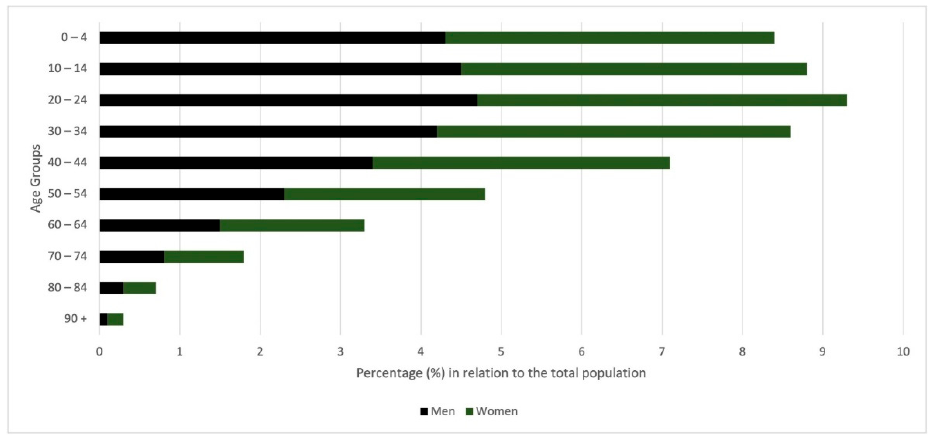
Figure 11. Brazilian Amazon age pyramid by sex, 2020. Source: [21]. The region will still benefit from a demographic bonus for longer than the rest of the country due to its late demographic transition, which was the result of slower declines in fertility. With a relatively younger workforce compared to the rest of Brazil, the Brazilian Amazon had, in 2019, 57% of people between 18 and 24 years old, and 40% of those be- tween 25 and 29 years old without any occupation. In this last age group, the occupancy rate was ten percentage points below that of the rest of Brazil [24]. The population concentration and demographic density in 2020 in the Brazilian Am- azon states can be seen in Table 12. Pará State was the most populous with 8.69 million inhabitants, followed by Maranhão at 5.91 million and Amazonas at 4.2 million [21]. Table 12. Area, population, and municipalities number in Brazilian Amazon. Source: [21]. States